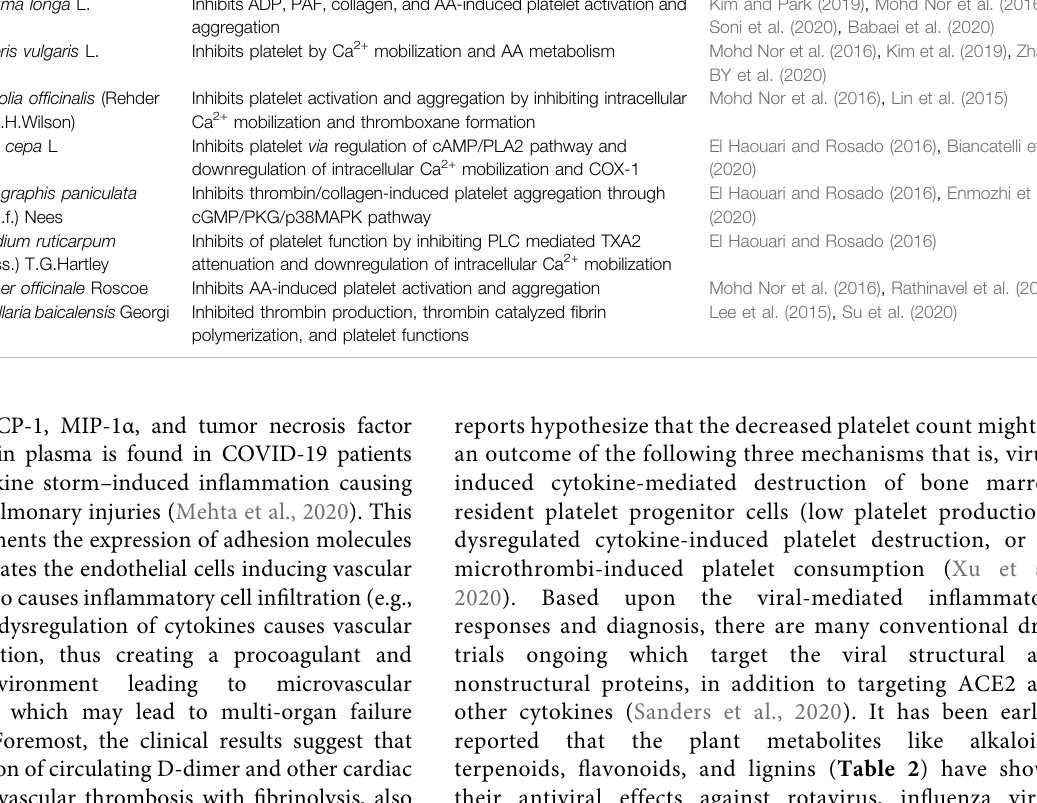
TABLE 2 | List of different phytochemicals having effect on platelet functions and thrombosis, which could have potential roles in the treatment of COVID-19.